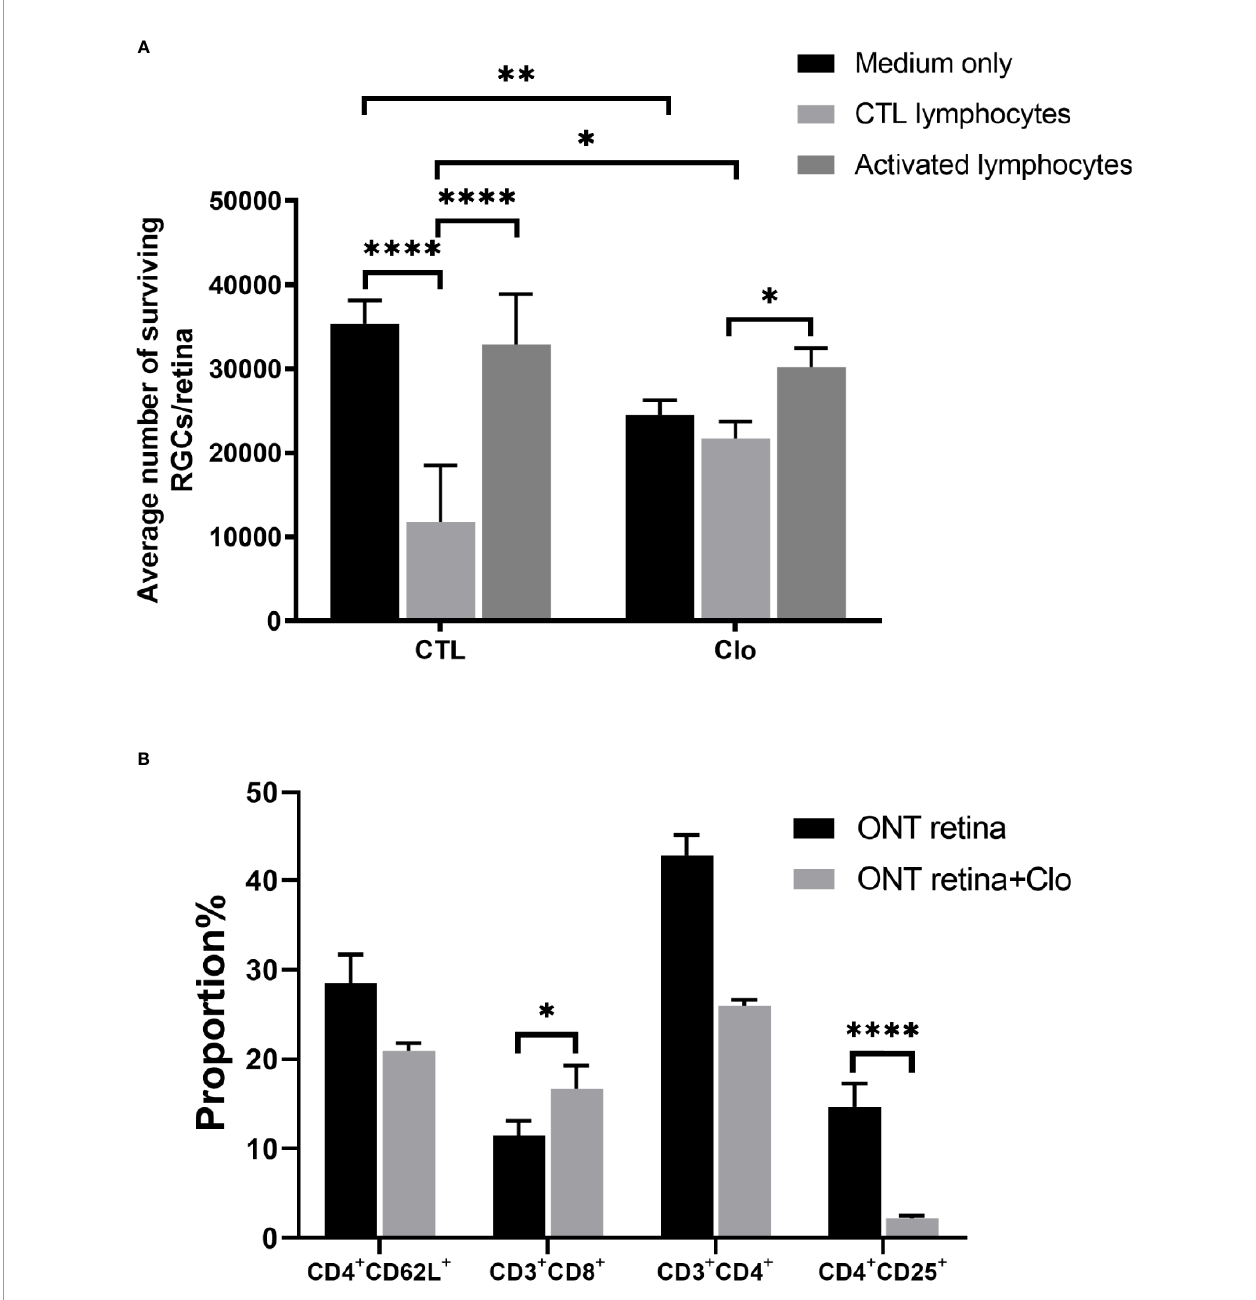
FIGURE 4 | Microglia/macrophages on the viability of RGCs (A) With the depletion of microglia/macrophages by clodronate, the number of RGCs was reduced in the medium-only group, slightly elevated in the CTL lymphocyte co-culture group, and unchanged in the activated lymphocyte co-culture group. (B) T cell subset analysis showed that CD3 + CD8 + cell numbers increased and CD4 + CD25 + cell numbers decreased. Clo=clodronate (n=4-6 for each group). * P < 0.05, ** P < 0.01, **** P <